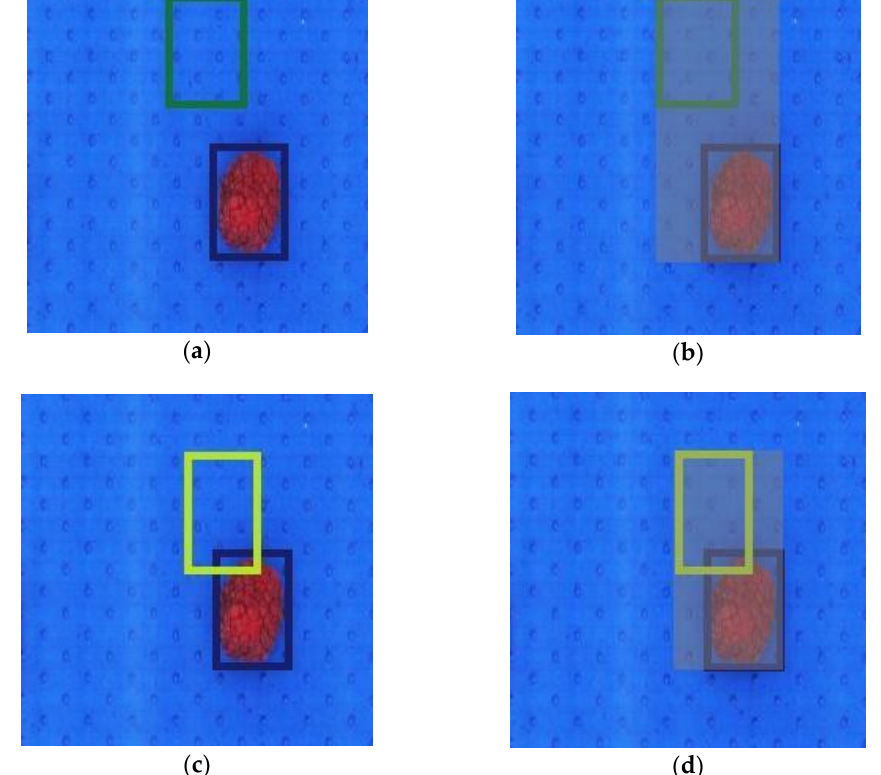
Figure 7. The cases when the predicted box ( a ) does not coincide at any point with real box: ( c ) has intersection with real box: ( b , d ) area C that serves to define how close the predicted box is to the real